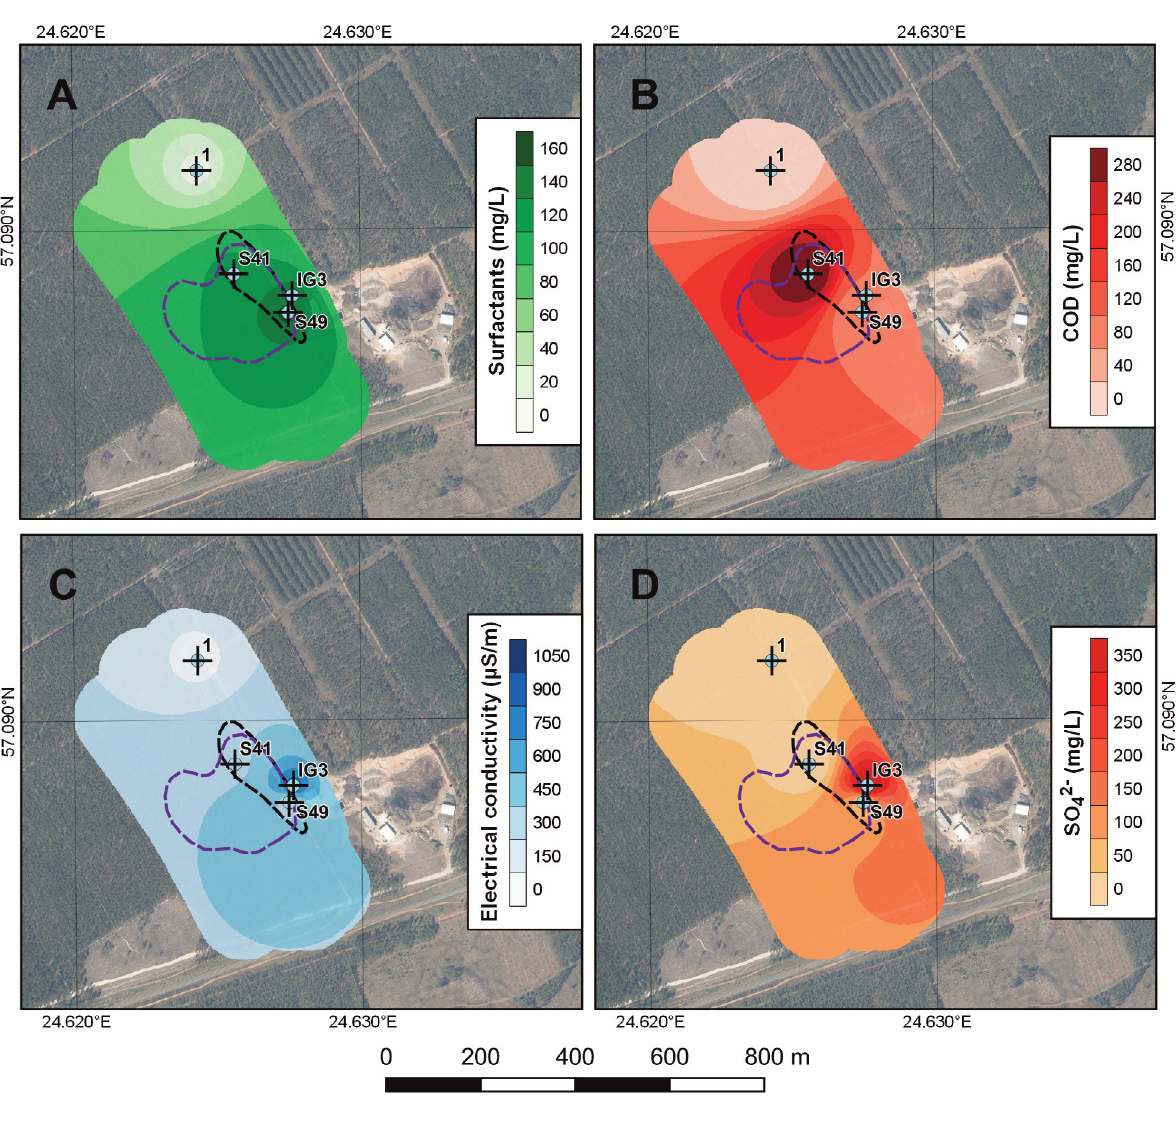
Fig. 5. Groundwater pollution that was determined at the boreholes (Ņelajevs 2019). A , concentration of surfactants in groundwater; B , chemical oxygen demand in groundwater; C , electrical conductivity of groundwater; D , concentration of SO 4 2– in groundwater. The black dashed line represents the high-conductivity zone determined by ground-penetrating radar. The purple dashed line represents the high-conductivity zone determined by electrical resistivity